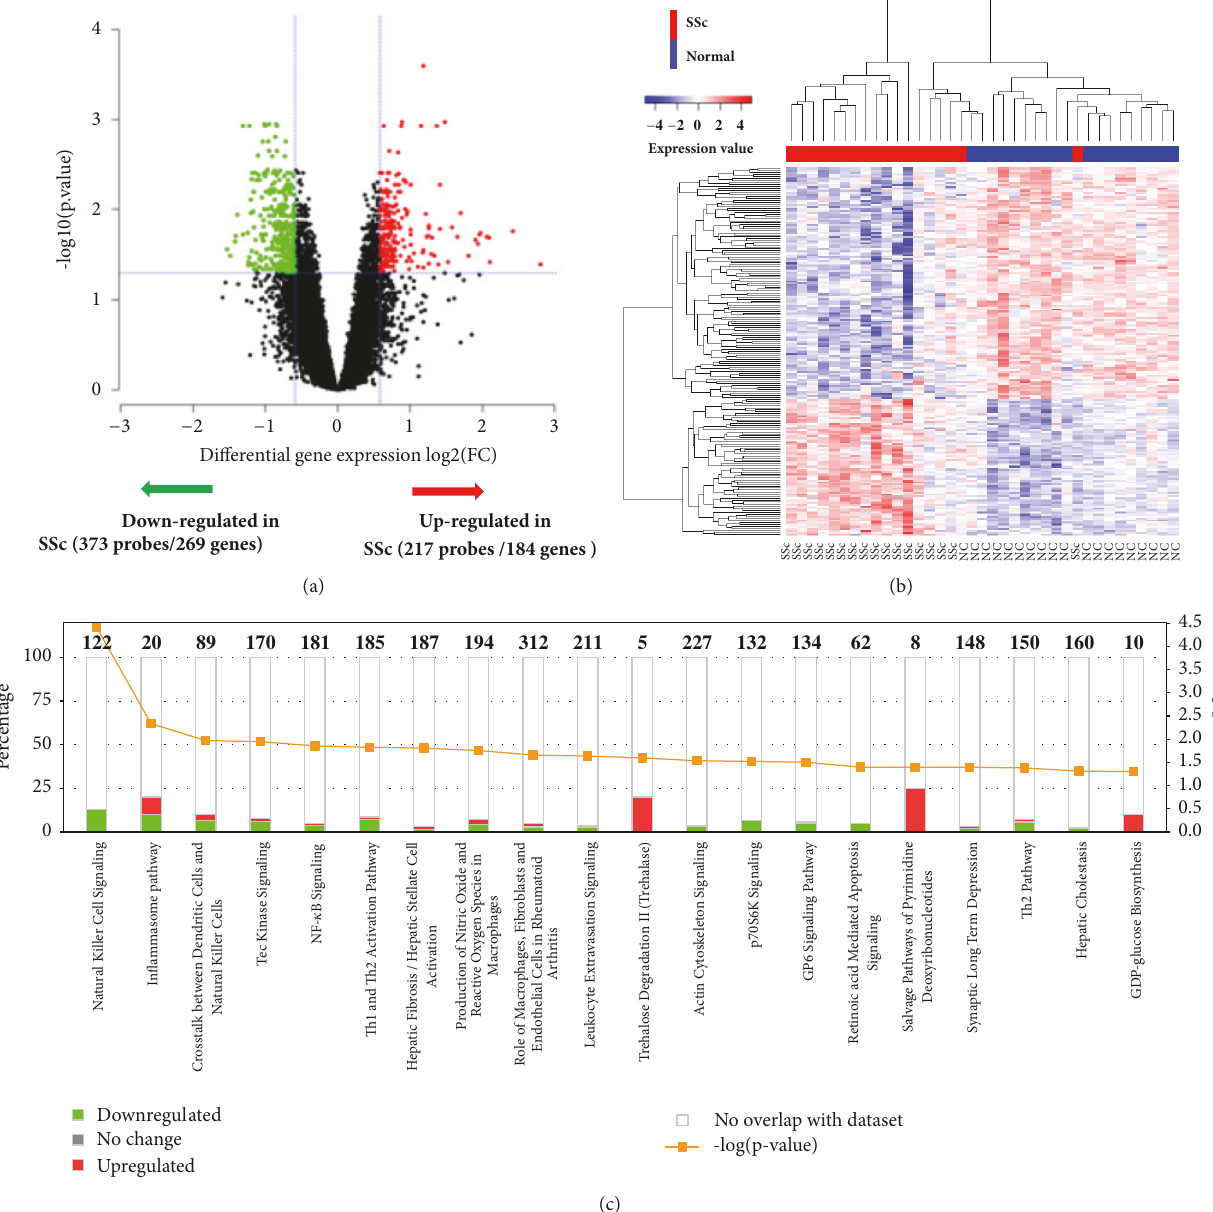
Figure 1: Identification of differentially expressed genes between systemic sclerosis and normal. (a) Volcano plot of the differential gene expression analysis. X-axis: fold change difference (log 2 scale); y-axis: BH-adjusted p values for each probe (- log10 scale). The vertical dotted lines represent absolute cutoff value of 1.5-fold change. The horizontal dotted line represents the significant cutoff of p < 0.05 (see SupplementaryTable2).(b)Two-dimensionalhierarchicalclusteringofdifferentialgeneexpressionprobes.Probesareshowninrows;samples are shown in columns. (c) Canonical pathway analysis of the differentially expressed genes in PBMC from SSc patients as compared with normal controls. Statistically significant pathways were shown. The 1 st y-axis indicates percentage of differential expression genes involved in the pathway. The 2 nd y-axis shows BH-adjusted p -value of enrichment